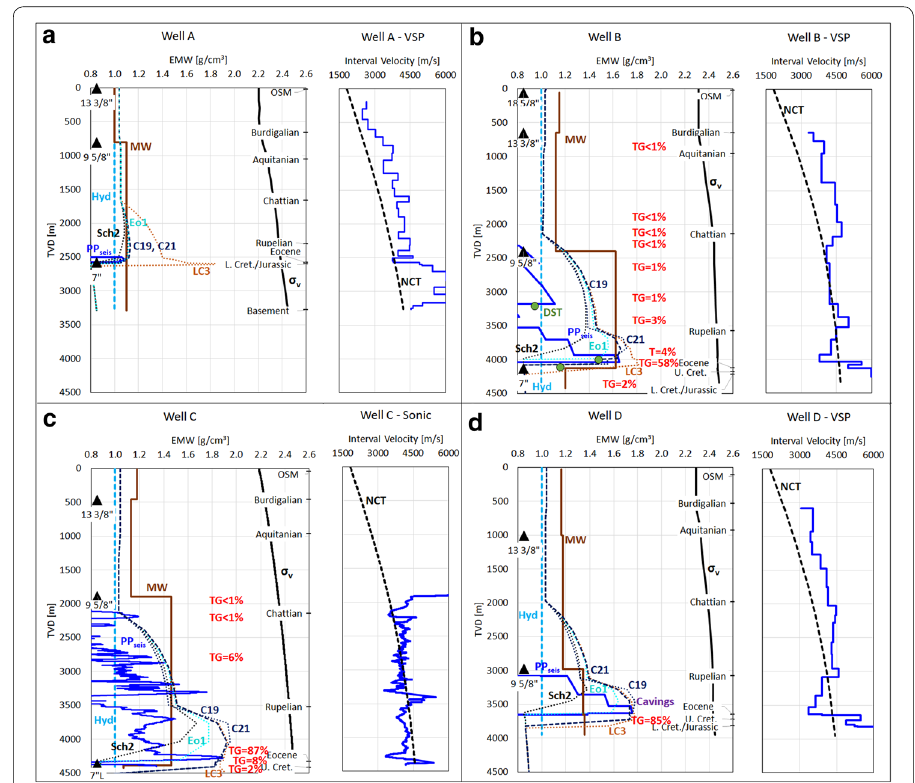
Fig. 8 Pore pressure overview and velocity data of the calibration wells. Depth in true vertical depth (TVD) from ground level, pressure and stress in equivalent mud weight (EMW) in g/cm 3 . a – d also show casing shoe depths (black triangles), drilling mud weight MW (brown line), hydrostatic pressure Hyd (dashed light-blue line), estimated pore pressure from VSP or sonic data (PP seis , blue line), estimated pore pressure from the 3D basin model (C19 dashed dark blue line, C21 dotted dark blue line, Sch2 dotted black line, LC3 dotted = = = = brown line, Eo1 dotted cyan line), vertical stress σ v (solid black line), total gas readings TG (red annotations) = and stratigraphic tops (black annotations). a Overview of Well A. Total gas data were not available. b Overview of Well B. The green dots represent drill stem test pressure data (DST). c Overview of Well C. d Overview of Well D. Pressure cavings are annotated in